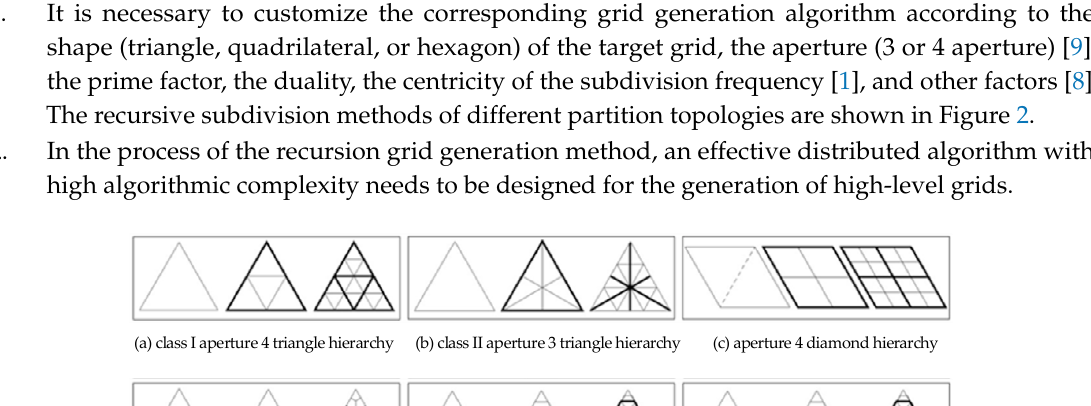
Figure 1. Typical subdivision grids.